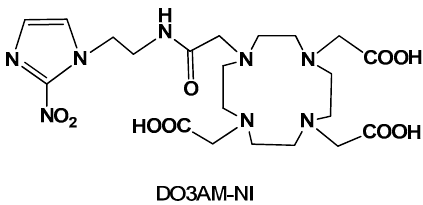
Figure 1. Chemical structure of the DO3AM-NI ligand.